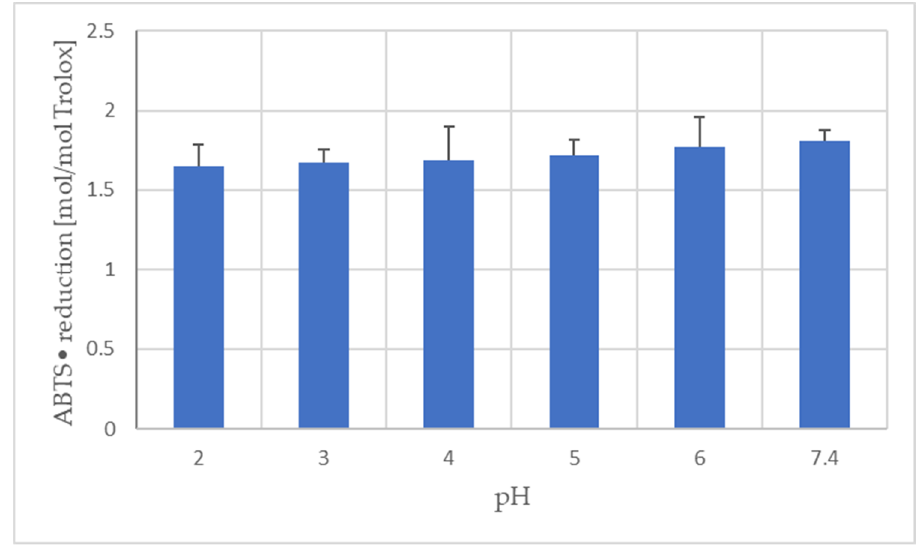
Figure 5. Effect of ionic strength on the self-decay of ABTS • . Decrease in ABTS • absorbance was monitored in phosphate buffer, pH 7.4, at various concentrations (10–500 mM).